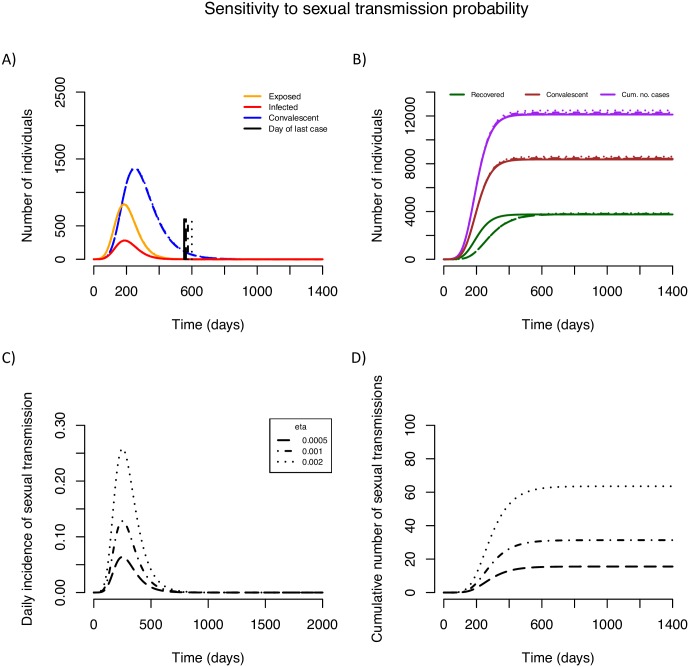
Effect of convalescent period on EVD epidemics.The average duration of the convalescent period (1/α) is varied between 3 and 9 months. (A, B): Epidemic trajectories in presence (broken lines) and absence of sexual transmission (solid lines). Vertical lines mark the day of last symptomatic case. (C) Daily incidence of sexual transmission. (D) Cumulative number of sexual transmission events. Note that the vertical axes vary across panels.